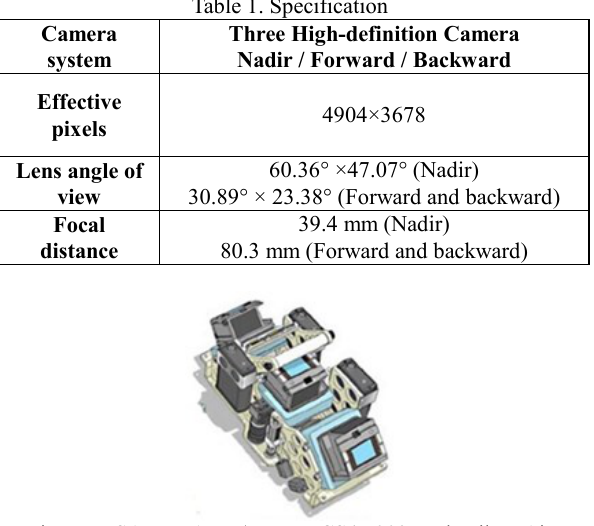
Figure 7. SAKURA III (NNK-DCS4H003, Nakanihon Air Service Co.,